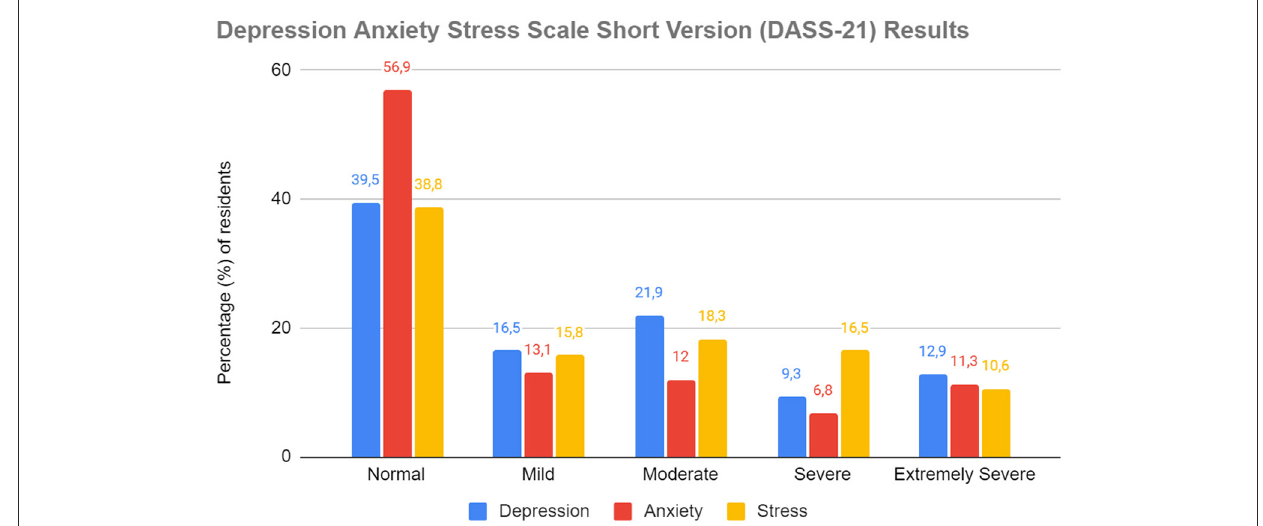
FIGURE1 Percentage of subjects affected by different levels of depression, anxiety and stress, according to the three subscales of the test Depression Anxiety Stress Scale short version, sorted according to the growing severity of the symptoms found (from “Normal” to “Extremely Severe”) (Public Health Residents’ Mental Health, Europe,